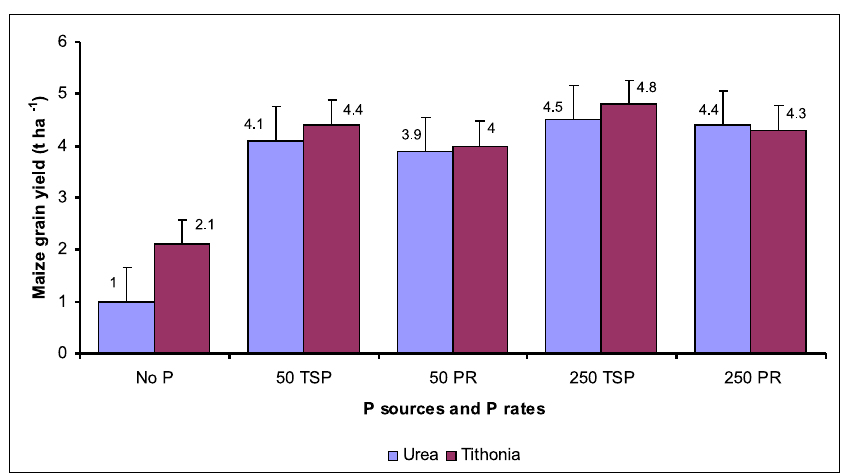
Fig. 1 – Maize responses to phosphorus and Tithonia applications in western Kenya. Average of 3 on-farm experiments summed over 5 cropping seasons (‘long rains’). The green foliar biomass of Tithonia diversifolia was incorporated into the soil at the beginning of the long-rains at the rate of 1.8 t dry matter ha -1 to provide 60 kg N ha -1 , 6 kg P ha -1 and 60 kg K ha -1 . Triple superphosphate (TSP) and Minjingu phosphate rock (PR) were added at a recapitalization rate of 250 kg P ha -1 (250) or annually at 50 kg P ha -1 (50). Blanket potassium application of 60 kg K/ha was added to each crop. Source: Bashir Jama (unpublished data).